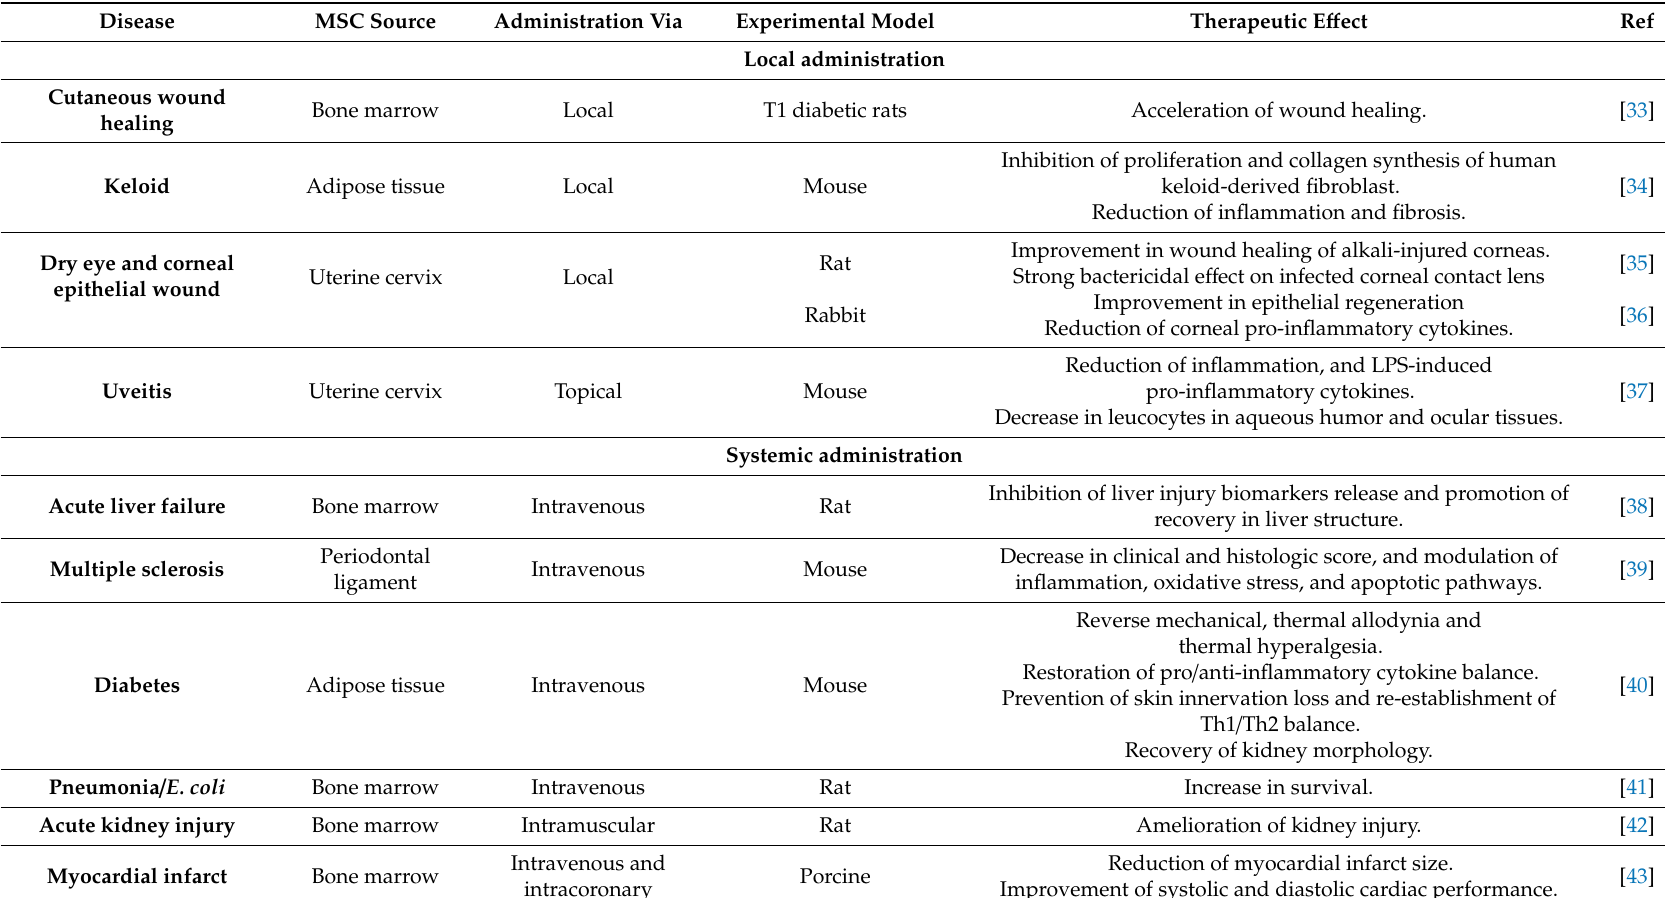
Table 2. Therapeutic e ff ects of MSC-derived conditioned medium on disease in vivo